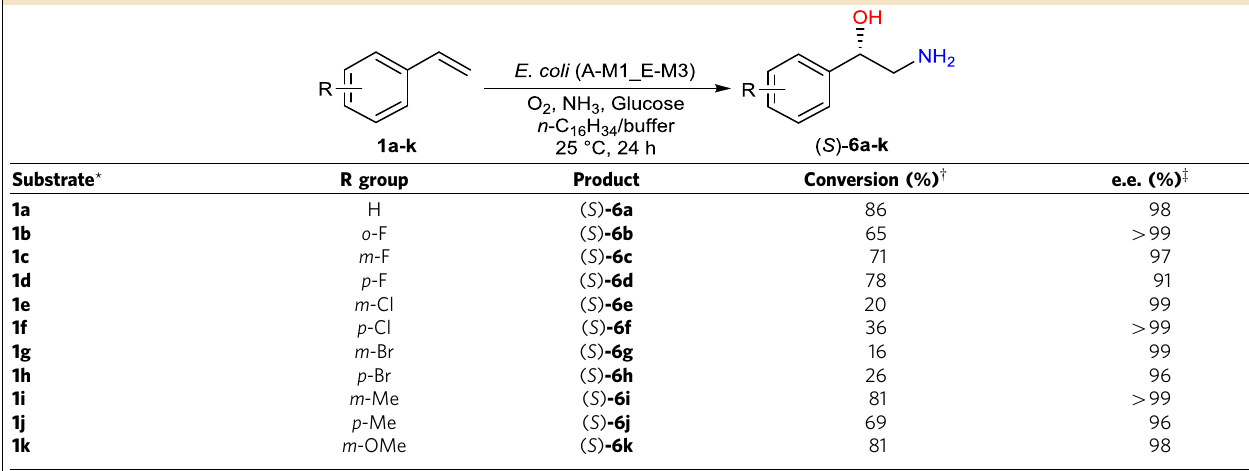
Table 3 | Regio- and enantioselective functionalization of terminal alkenes 1a–k to 1,2-amino alcohols 6a–k with E. coli (A-M1_E- M3) via cascade